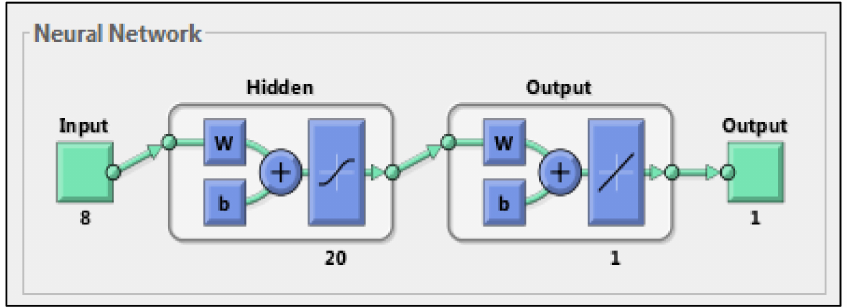
Figure 8. ANN configuration applied to data with statistical moments.